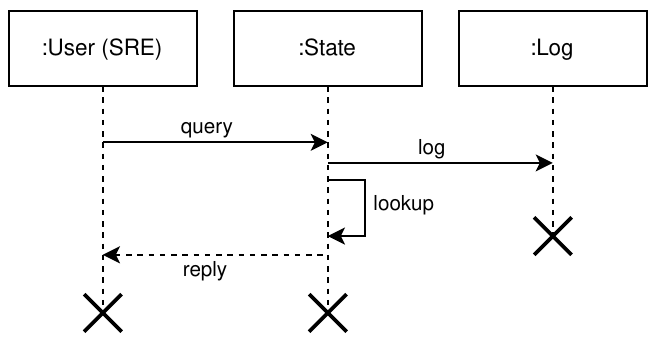
Figure 6. High level query operation